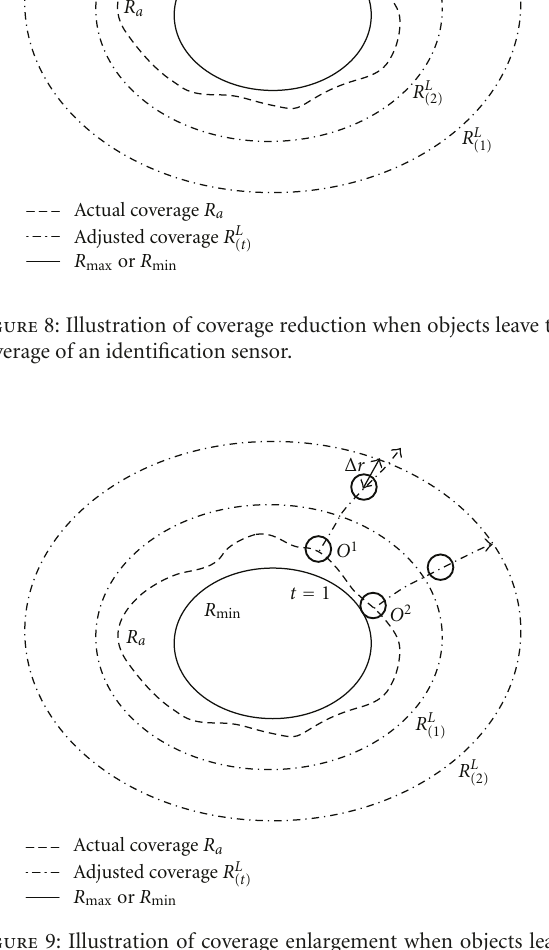
Figure 7: Illustration of coverage enlargement when objects enter the coverage of an identification sensor.